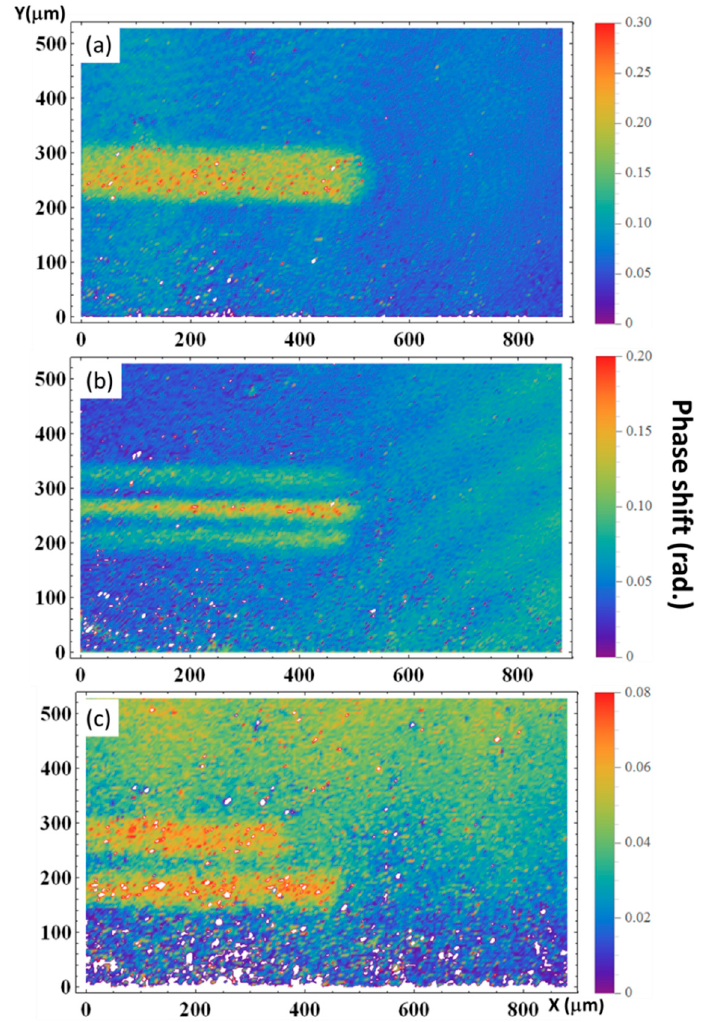
Figure 2. Phase shift in plasma channel registered by means of interferometry. ( a ) Beam without a mask; ( b ) A vertical orientation of the amplitude mask, simultaneous pulses, and interaction of filaments; ( c ) A vertical orientation of the amplitude mask, delayed pulses, thus, independent filaments. The pump pulse energy in all cases is 0.95 mJ. For all distributions, the probe delay was set at “0” position for the central region of image.